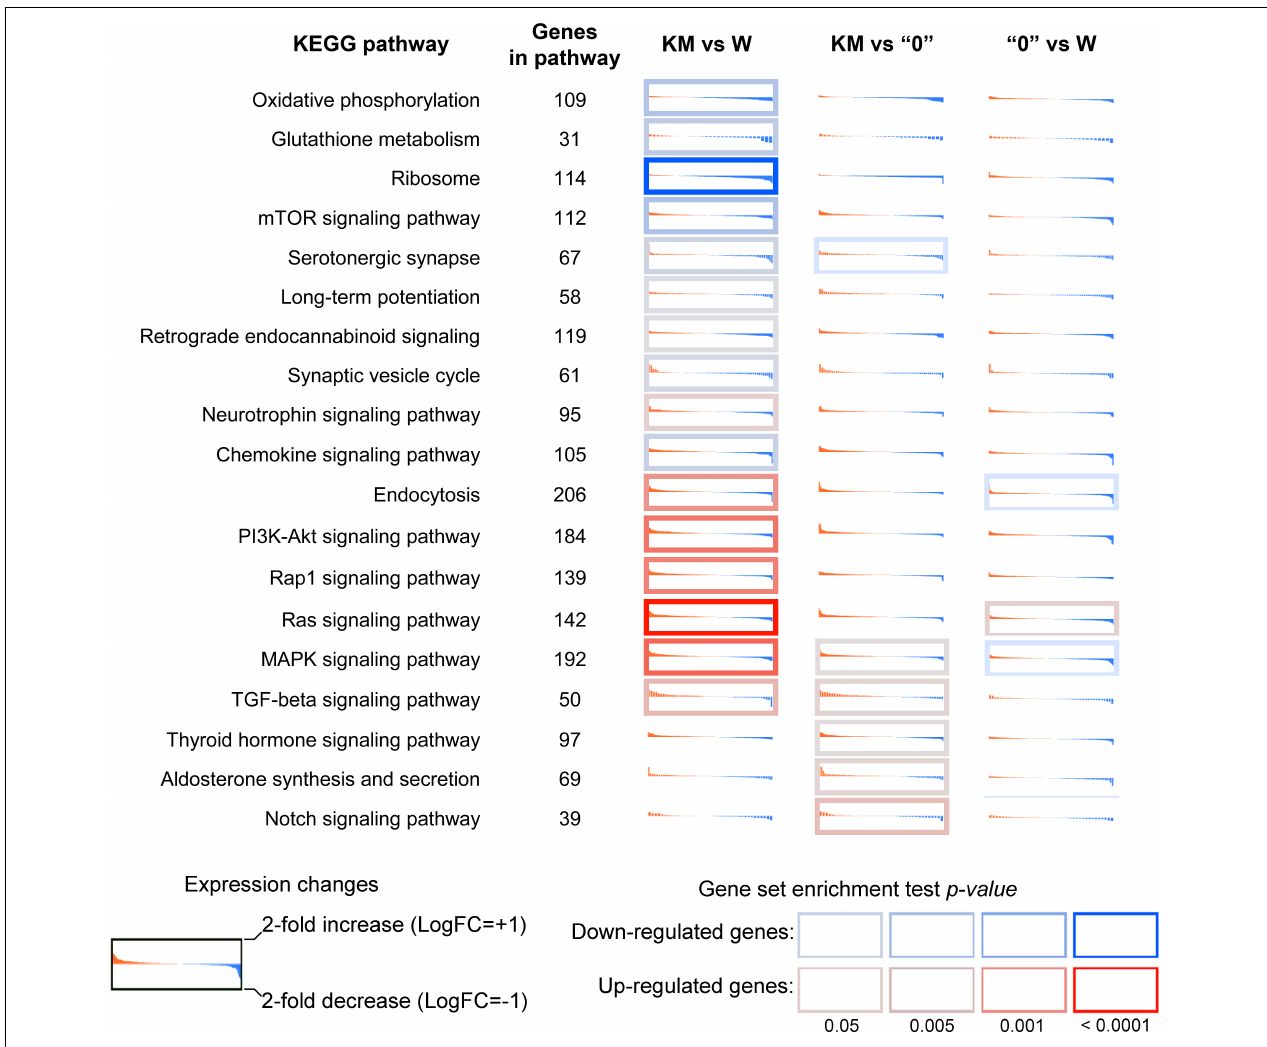
FIGURE 2 | Differential expression profiles of genes participating in the most affected KEGG pathways in the KM, W, and “0” rats. For each KEGG term, genes were identified (irrespective of p -value) and sorted by decreasing log2-fold change. Red-to-blue sub-plots illustrate expression level changes (log-scale, with values decreasing across the plot). The log2 expression level fold change (LogFC) range extends from − 1 (i.e., 2-fold downregulation; blue) to +1 (i.e., 2-fold overexpression; red). The cell border indicates the gene set enrichment (GSEA) p -value for a pathway. A red border indicates that a KEGG pathway is enriched with upregulated genes; a blue border indicates that a KEGG pathway is enriched with downregulated genes. The p -value was calculated for up- and downregulated genes using Fisher’s exact